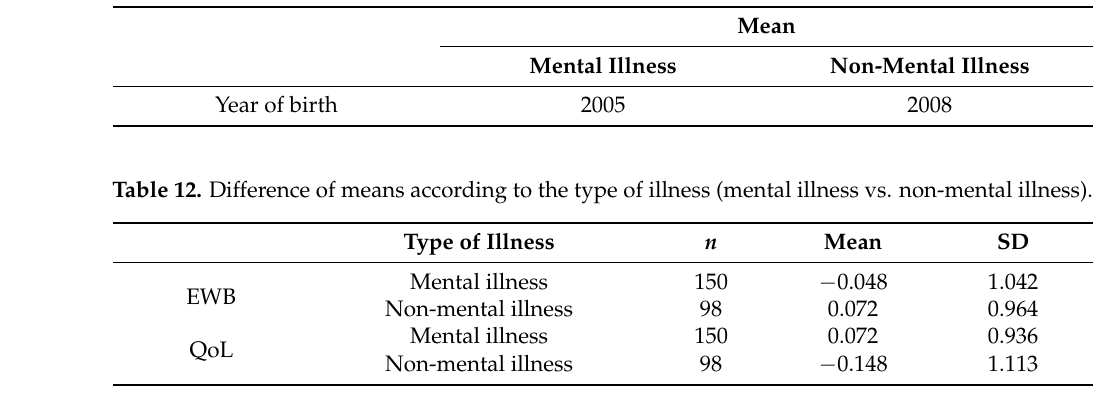
Table 11. Age means according to the type of illness (mental health vs. non-mental health).